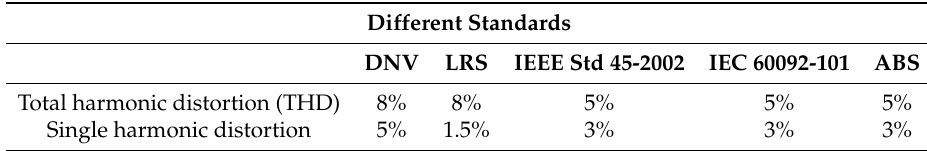
Table 7. Harmonic voltage distortion limitation in shipboard power